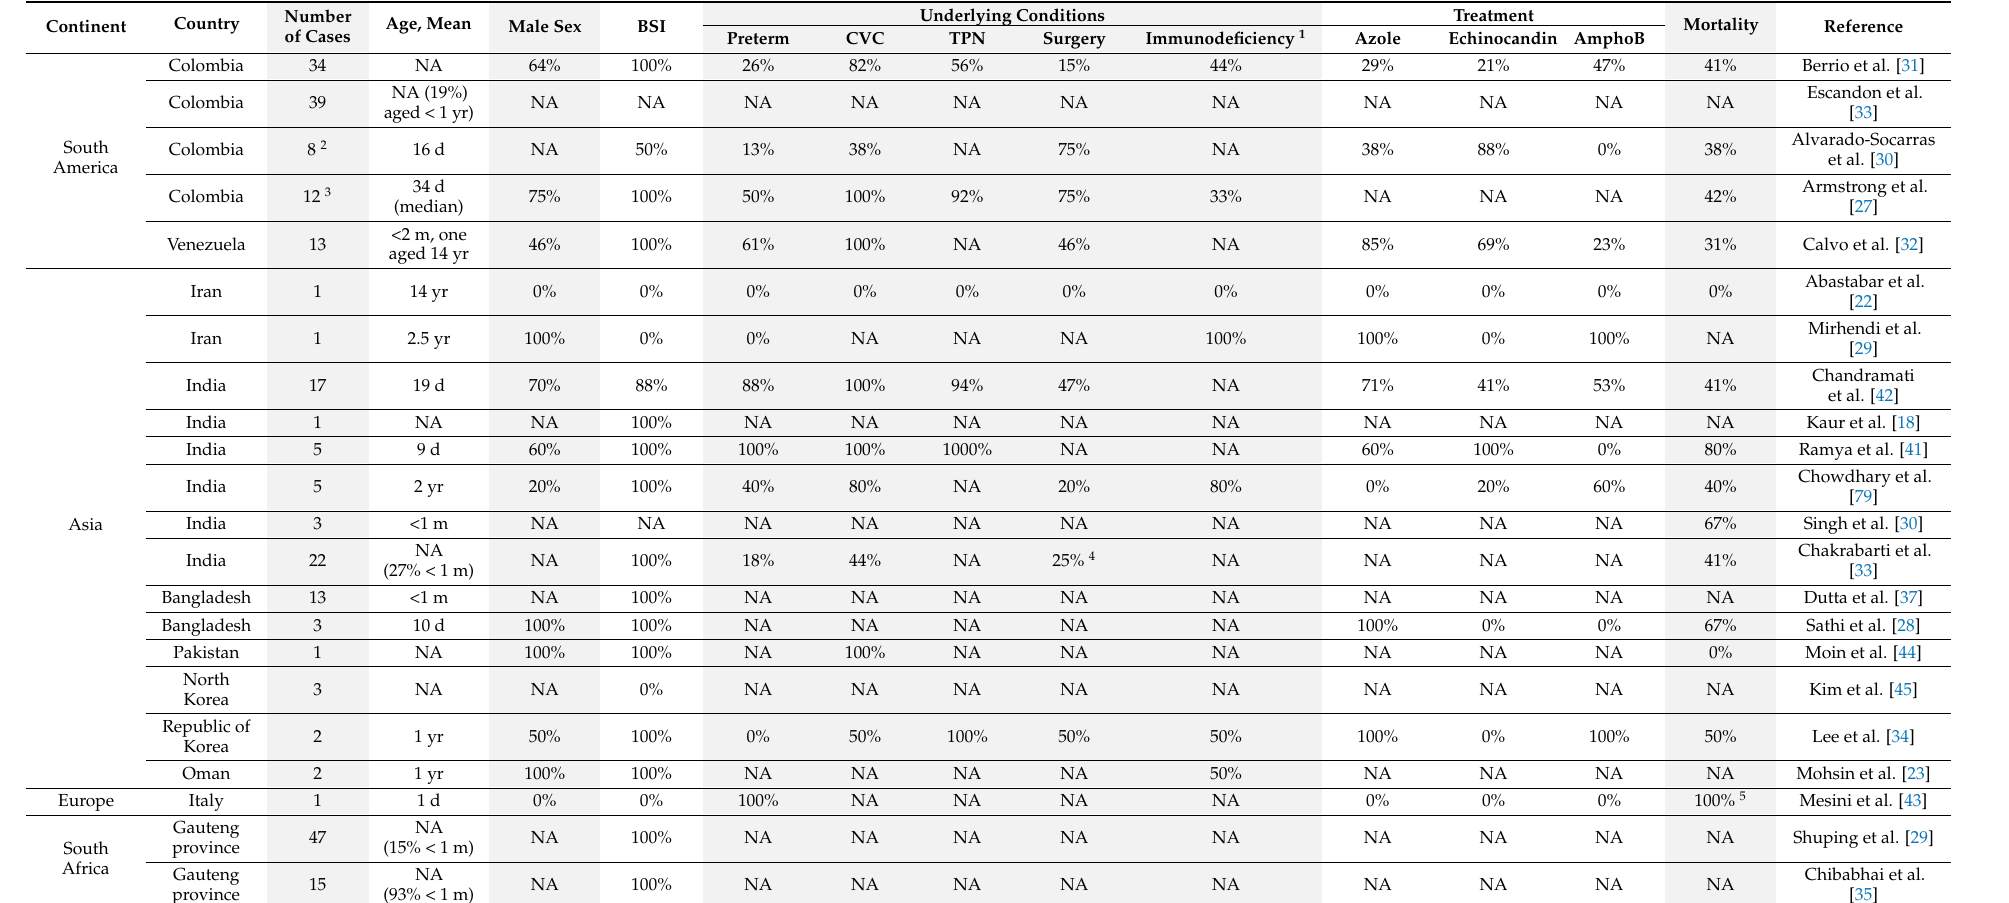
Table 3. Demographic and clinical characteristics of children with C. auris infection or